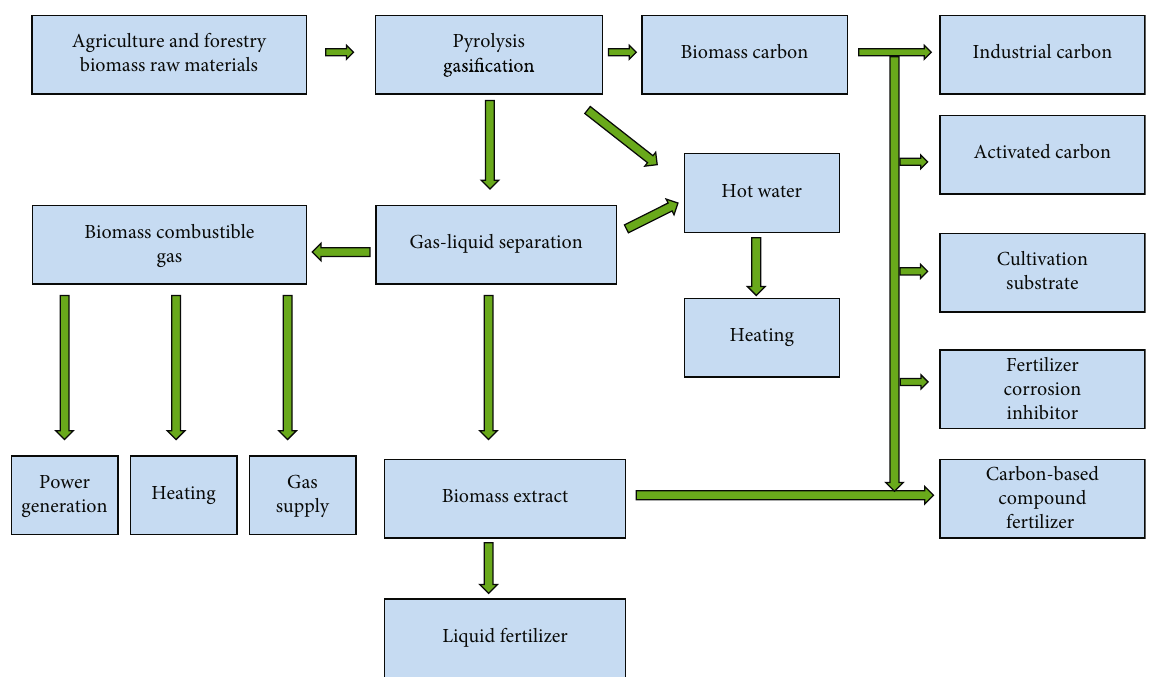
Figure 1: Biomass energy recycling